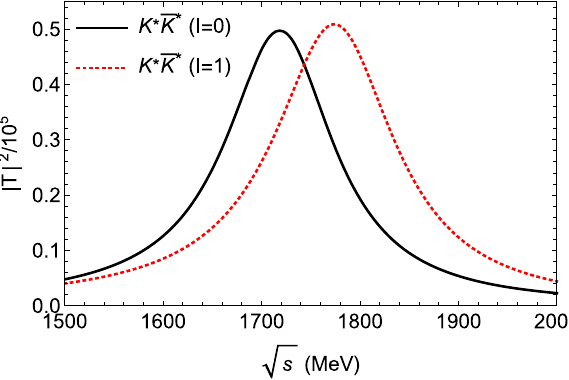
Fig. 3 Squared modulus of amplitudes ( | T | 2 ) for the elastic reactions of K ∗ ¯ K ∗ with I = 0 and I = 1, according to the Breit–Wigner parametrization of the“real axis” approach reported in Ref.